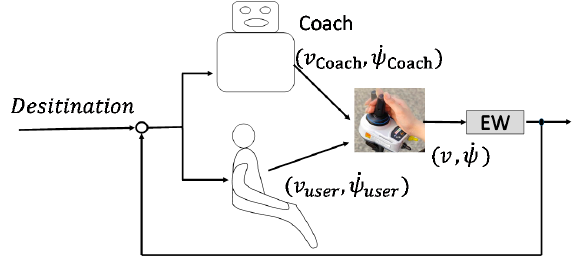
Figure 4. Shared control system concept.